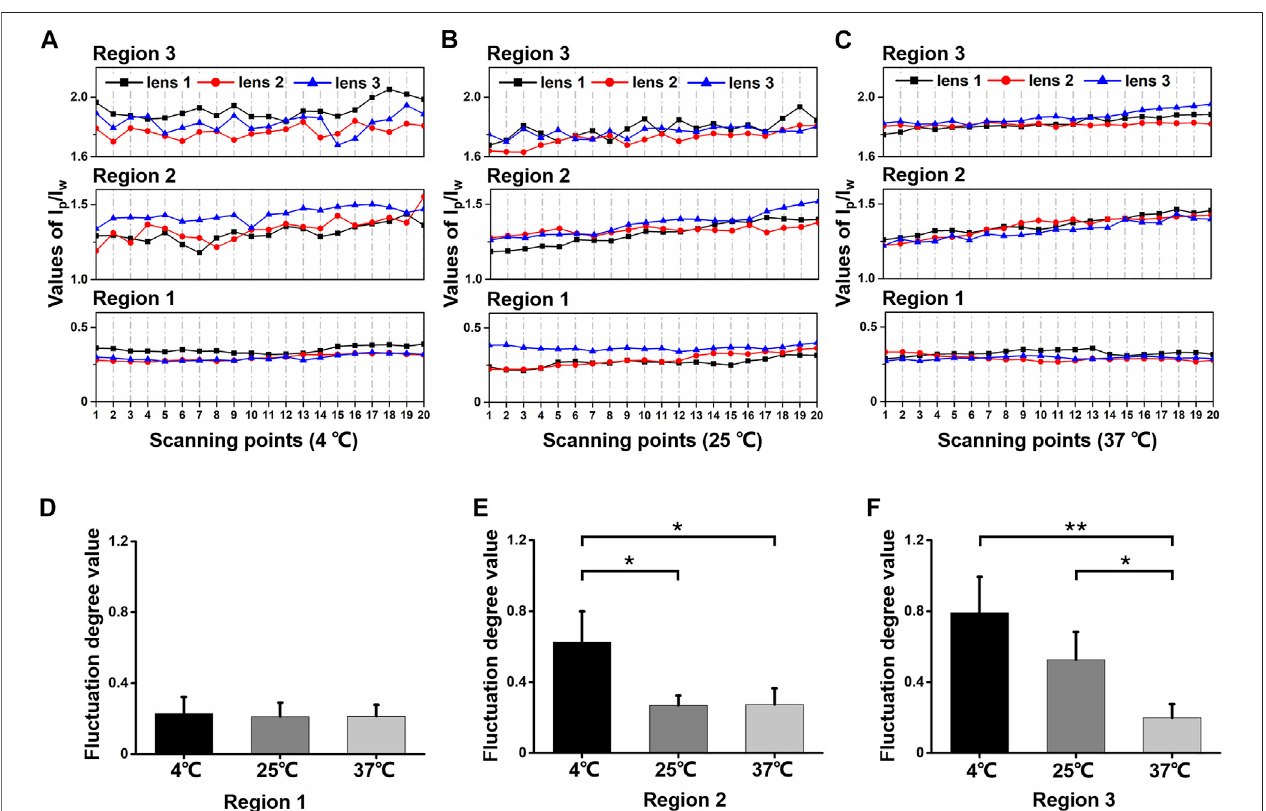
FIGURE 4 | The I p /I w values for different regions and different temperatures. (A – C) Scattered-line plots of I p /I w value for each scanning region at 4 ° C, 25 ° C, and 37 ° C. In each small plot, the display regions of the values were set equal as 0.6. (D – F) The value of fl uctuation degree for regions 1, 2 and 3 at different temperatures, separately (* p ≤ 0.05, ** p ≤ 0.01).